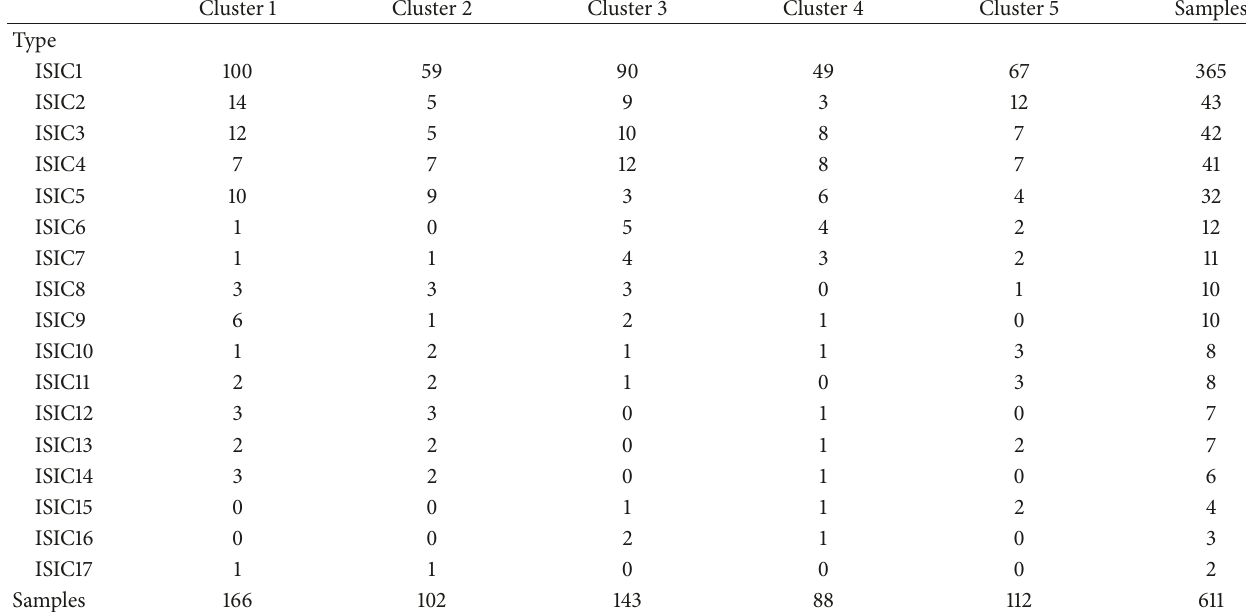
Table 11: Contingency table showing the distribution of project type among the clusters (see Table 5 for details about the project type codes). Cluster 1 Cluster 2 Cluster 3